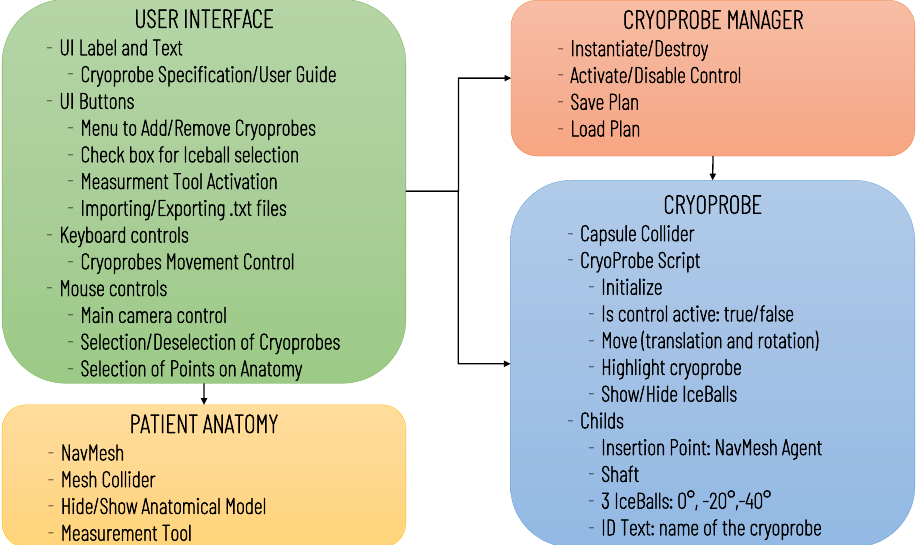
Figure 1. Diagram of the virtual simulator software architecture illustrating the main software modules and the data transfers between